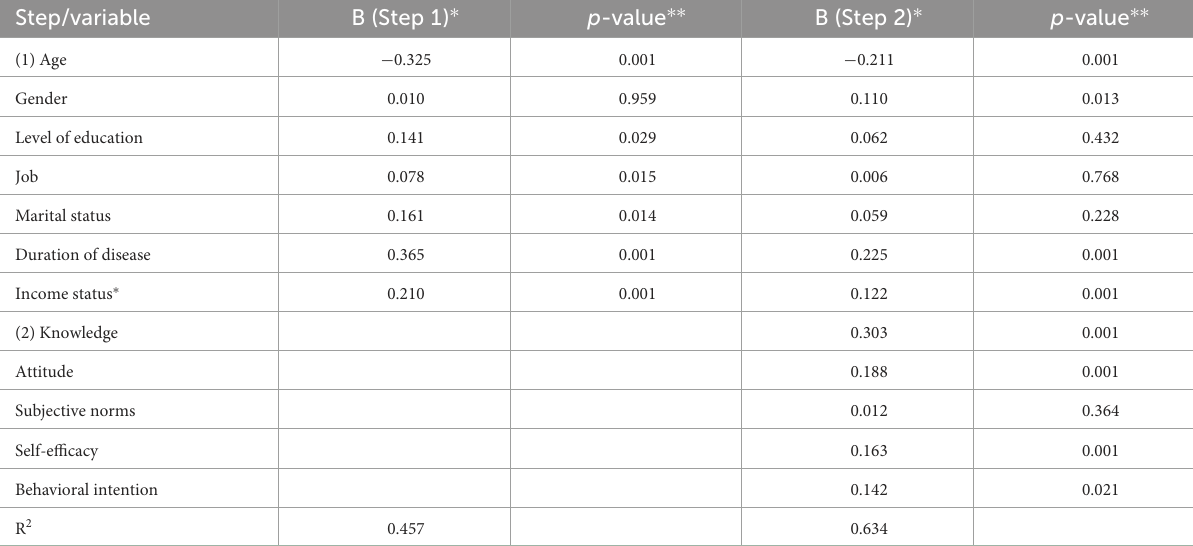
TABLE 4 Hierarchical regression analysis to predict self-care behaviors among diabetic patients. Step/variable